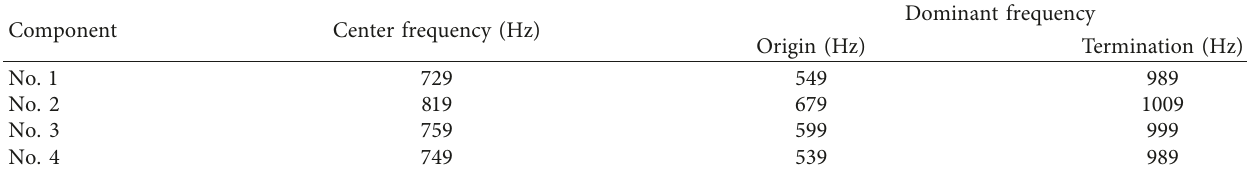
Table 2: Frequency parameters of the MS event in Figure